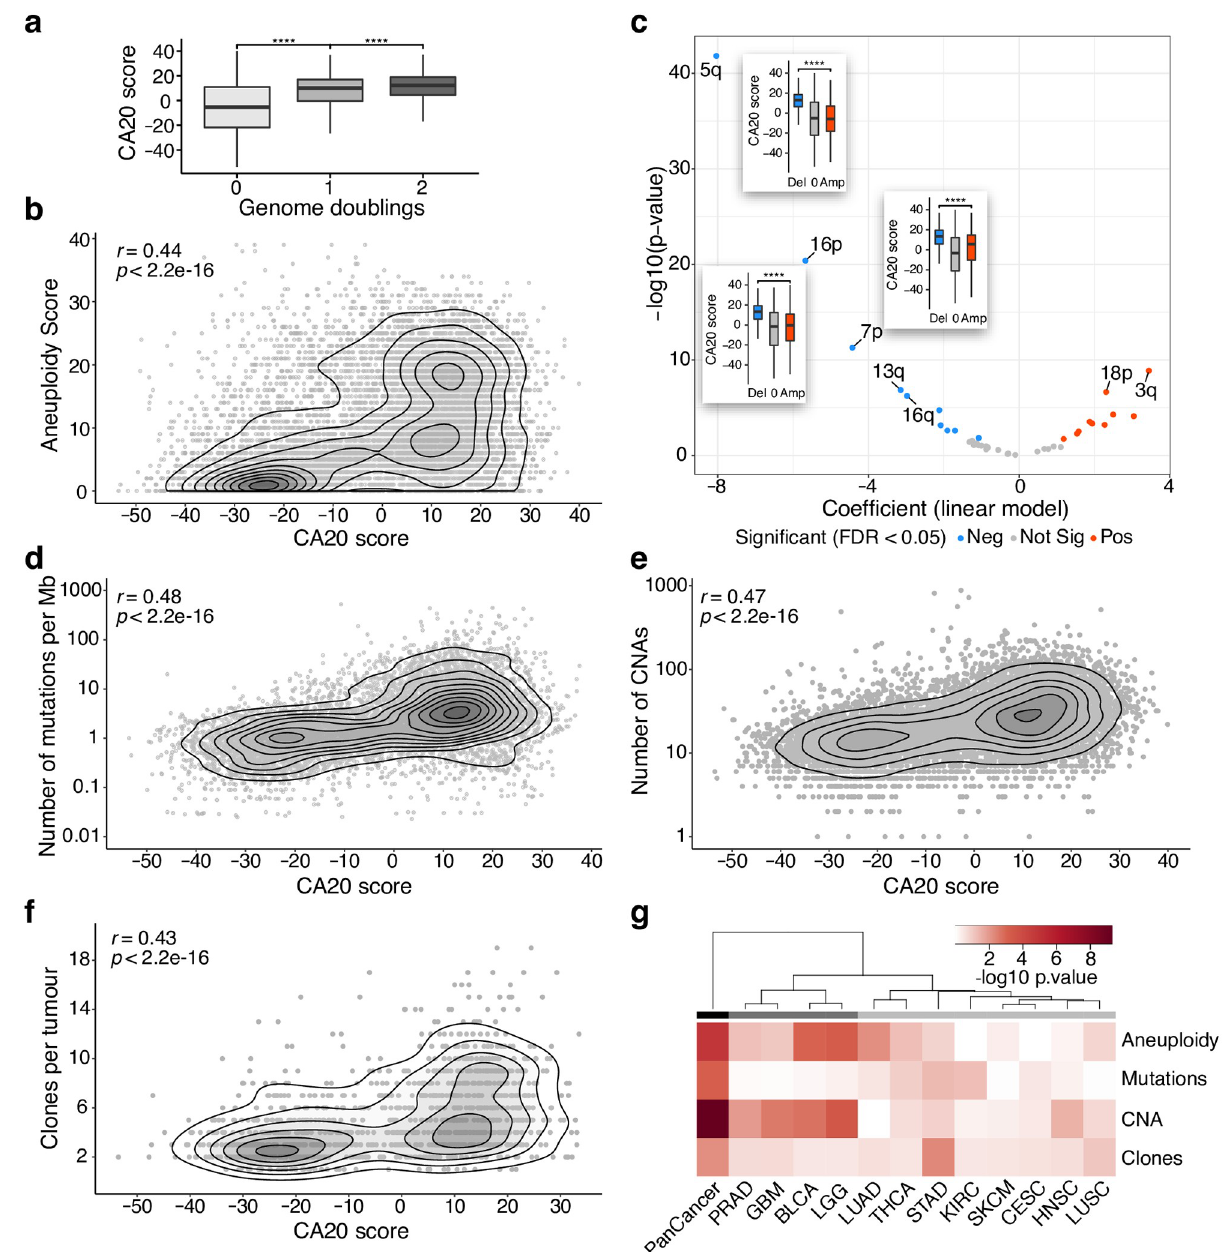
Fig 3. CA20 is associated with genomic instability features in cancer. ( a ) CA20 score is associated with genome doubling. Box plots of CA20 score per whole genome doubling status. ���� p-value < 0.0001 (Wilcoxon rank-sum test). ( b , d - f ) CA20 is associated with different genomic instability features. Smooth scatter plots showing correlation between CA20 score and ( b ) aneuploidy score (measured as the total number of altered chromosome arms), ( d ) number of mutations per Mb, ( e ) number of CNAs and ( f ) clones per tumour across TCGA tumour samples (Spearman’s correlation coefficient, r = 0.44, 0.48, 0.47 and 0.43, respectively, p-value < 2.2e-16 for all). ( c ) Chromosome arm alterations associated with CA20 score. Volcano plot shows the results of linear regression analyses comparing CA20 score between samples with deletion or amplification of each chromosome arm. Arms whose deletions or amplifications are associated with higher CA20 (FDR < 0.05) are represented in blue and red, respectively. Chromosome arms with FDR < 1e-5 are highlighted and box plots of CA20 score per chromosome arm alteration are shown for 5q, 16p and 7p arms. ���� p- value < 0.0001 (linear regression). ( g ) Hierarchical clustering of TCGA cancer types based on the independent association between the different genomic instability features and CA20 score. Unsupervised hierarchical clustering using Euclidean distances calculated based on multiple linear regression p-values of association with CA20 of aneuploidy score, number of mutations per Mb, number of CNAs and clones per tumour, per TCGA cohort and with all cohorts together (PanCancer). Heatmap colour scale according with -log10 of linear regression p-values. Main clusters are highlighted with different shades of grey. BLCA: bladder urothelial carcinoma; CESC: cervical squamous cell carcinoma and endocervical